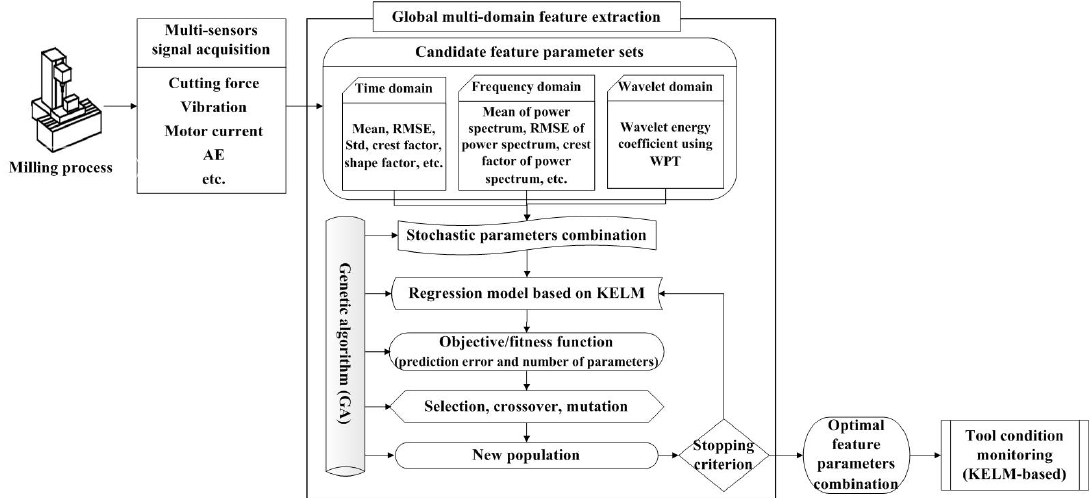
Figure 1. Framework of the proposed tool condition monitoring method. AE: Acoustic emission, RMSE: Root mean square error, WPT: Wavelet packet transform, KELM: Kernel extreme learning machine.